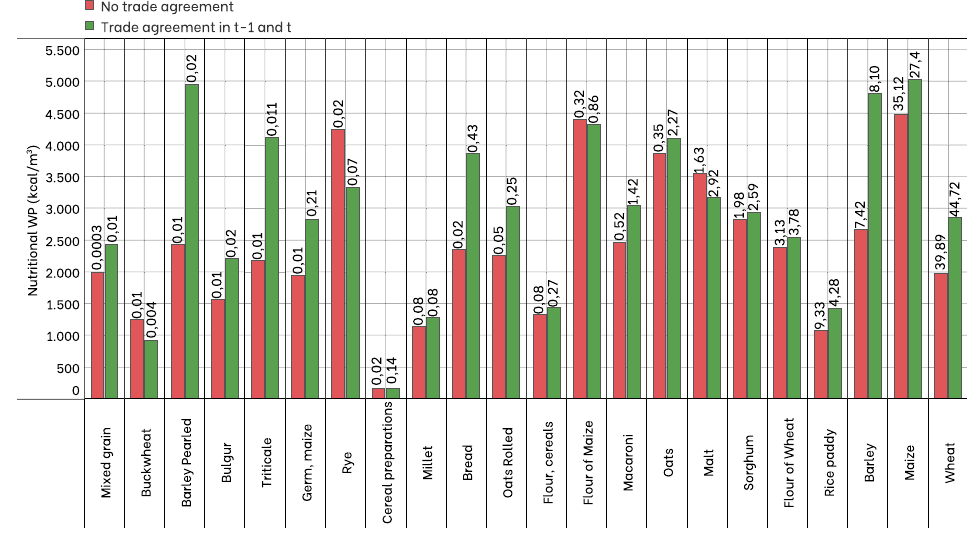
Figure 4. The bar chart shows the nutritional WP for each cereal product in the two sets of Trade agreement in t-1 and t (in green) and No trade agreement (in red). The number over the bars represents the percentage of kcal traded for each product compared to the total kcal of all cereals. Note that green bars are higher than the red ones in 80% of